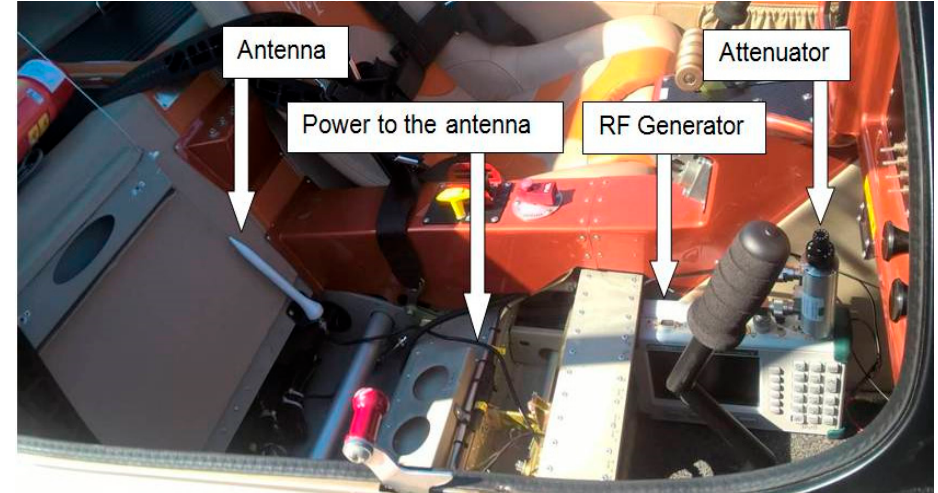
Figure 5. Location of the HF generator in the cabin of the aircraft.